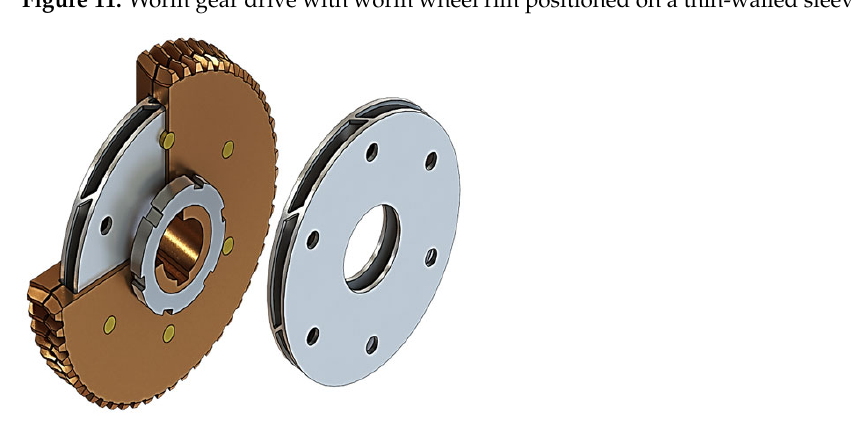
Figure 12. Split worm wheel with internally hollowed-out half and flexible disc converting a slight deformation towards the worm axis into rotational deformation around this axis.